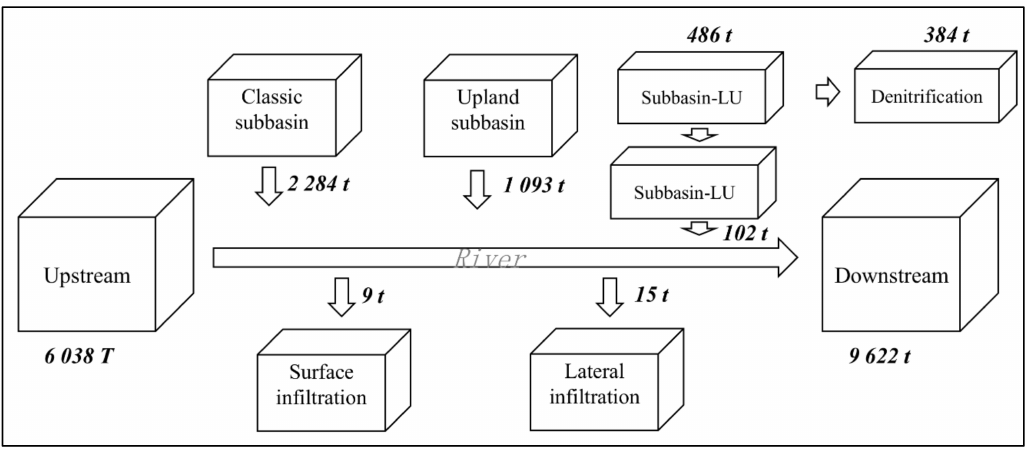
Figure 8. Annual nitrate (N-NO 3 − ) balance in the study area.